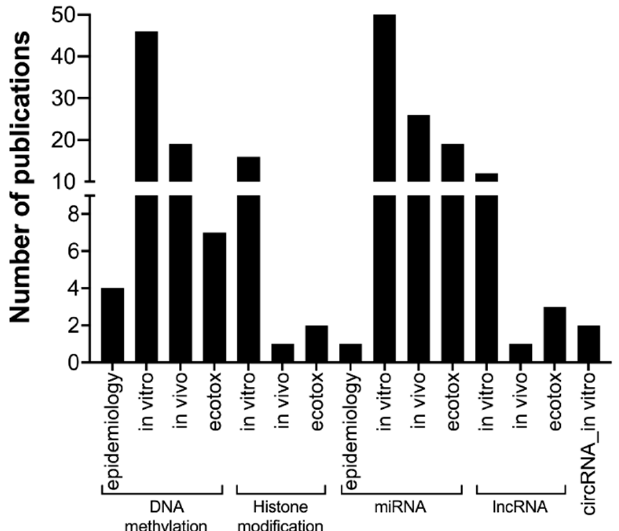
Figure 6. The nanomaterial ‐ induced alterations in different epigenetic biomarkers based on various model systems (the figure is generated with the numbers of published papers appearing in the PubMed database with a specific keyword search; epidemiology mainly represents “occupational exposure” ‐ related studies; in ecotoxicology, model species include mainly zebrafish, yeast, and C. elegans ).